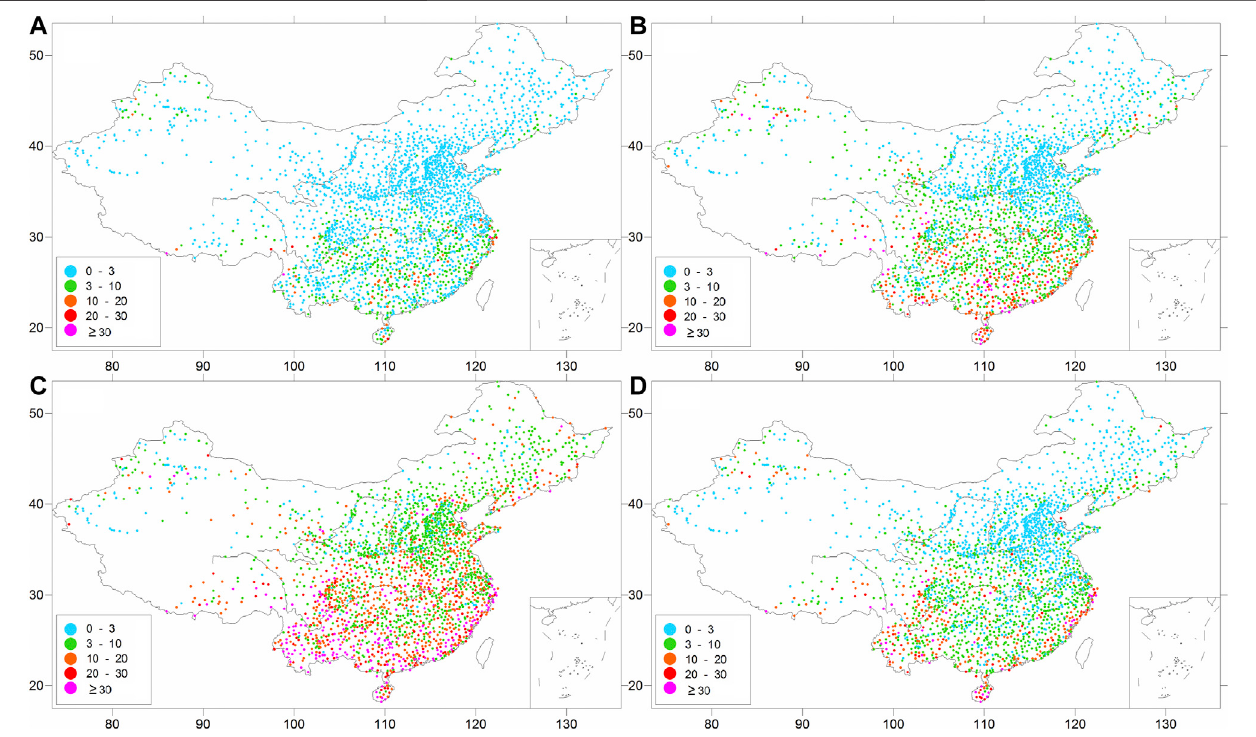
Frontiers in Environmental Science |